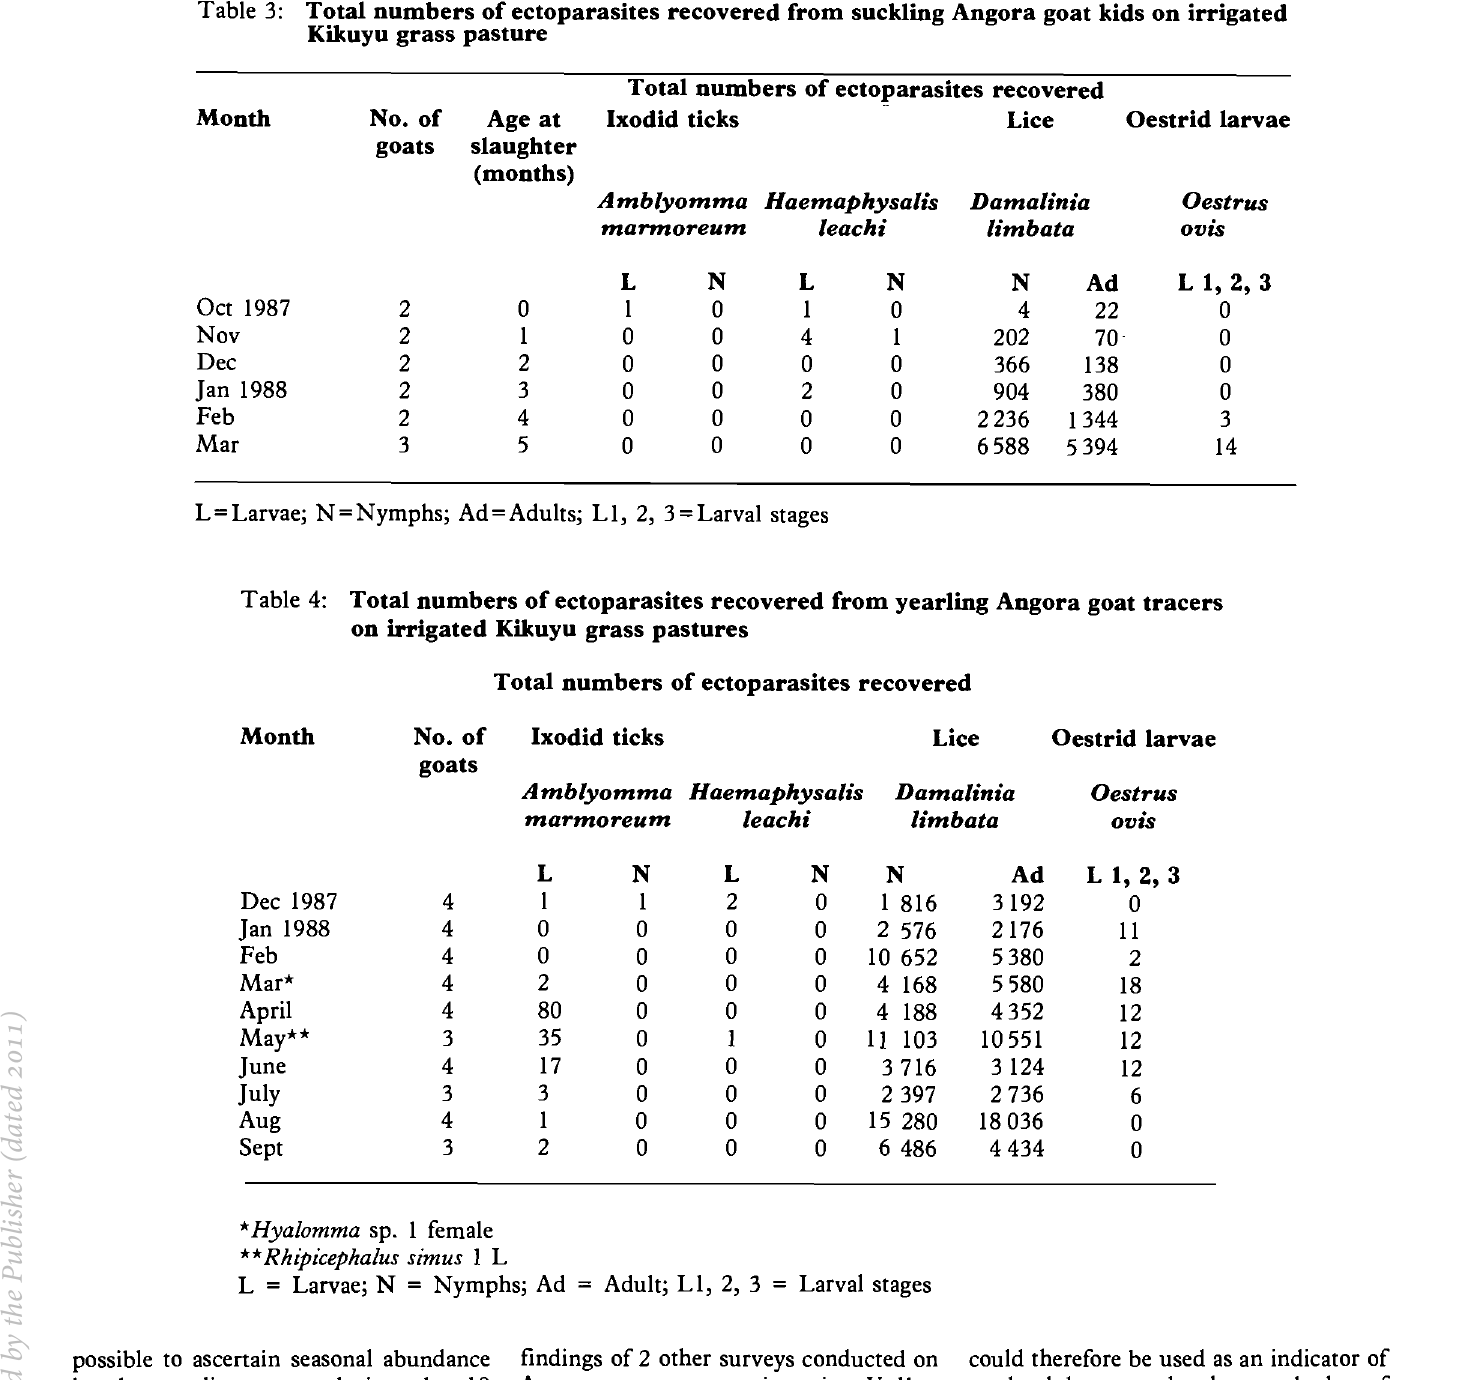
Table 3: Total numbers of ectoparasites recovered from suckling Angora goat kids on irrigated Kikuyu grass pasture Total numbers of ectoparasites recovered